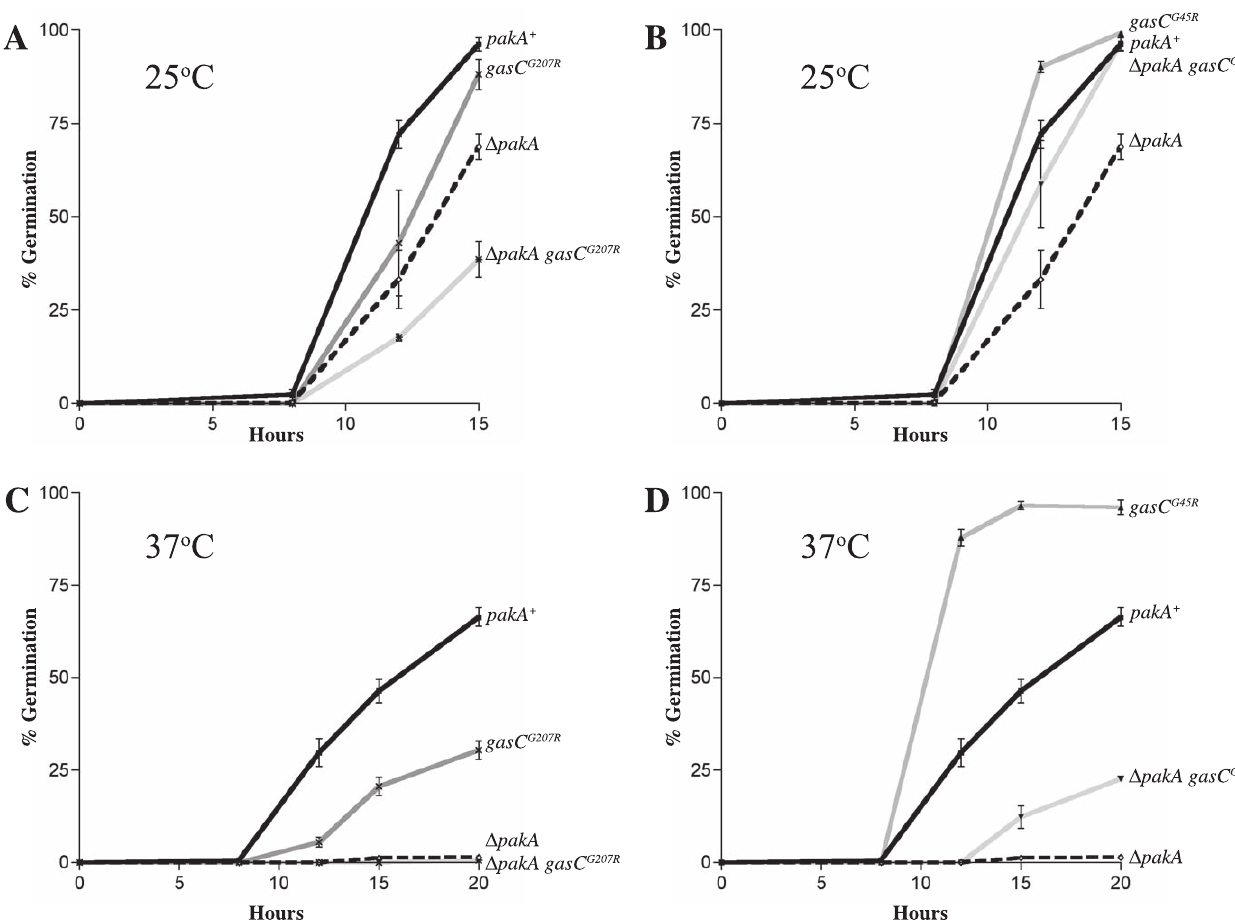
Figure 7. Expression of the Dominant Activated gasC G45R Allele Partially Suppresses the Germination Defect of the D pakA Mutant The percentage of germinated conidia was measured in the wild-type ( pakA þ ), D pakA , gasC G207R , gasC G45R , D pakA gasC G207R , D pakA gasC G45R strains after incubation at 25 8 C for 8, 12, and 15 h (A and B) and at 37 8 C for 8, 12, 15, and 20 h (C, D). One representative strain of each genotype is shown. Three independent experiments were performed. Standard error of the mean bars are shown. Compared with wild type ( pakA þ ), the D pakA mutant has delayed germination at 25 8 C (A, B). (A) At 25 8 C, the gasC G207R strains show delayed germination compared with wild type. D pakA gasC G207R strains display delayed germination that is lower than the D pakA and gasC G207R single mutant strains. (B) At 25 8 C, the gasC G45R strains show accelerated germination compared with wild type. The D pakA gasC G45R strains exhibit germination kinetics similar to wild type. (C, D) The D pakA mutant has a severe germination defect at 37 8 C. (C) The gasC G207R strains show delayed germination at 37 8 C. D pakA gasC G207R strains display severely reduced germination similar to the D pakA strain. (D) Compared with wild type ( pakA þ ), gasC G45R strains show accelerated germination at 37 8 C. D pakA gasC G45R strains show germination that is intermediate between wild type and the D pakA strain.